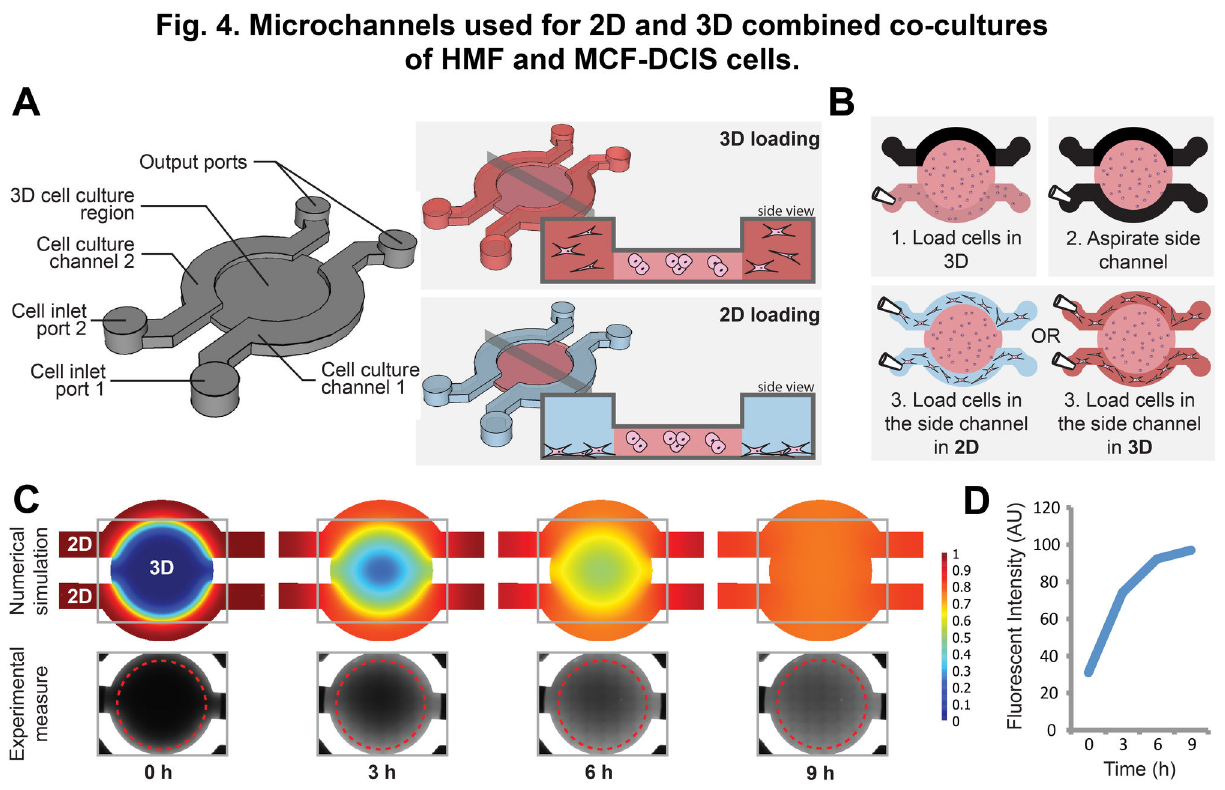
Figure 4. Microchannels used for 2D and 3D combined co-cultures of HMF and MCF-DCIS cells. (A) 3D schematic and cross-section of the microchannels used for 2D and 3D combined co-culture of HMF and MCF-DCIS cells. (B) Illustrations of the loading process showing the simplicity of loading both in 2D and 3D conditions. (C) Visualization of the diffusion process in the microdevice using a numerical COMSOL simulation and a timelapse microscopy of AlexaFluor488-Dextran10kD dye. (D) Average fluorophore concentration in the inner chamber of the microdevice plotted through time. doi: